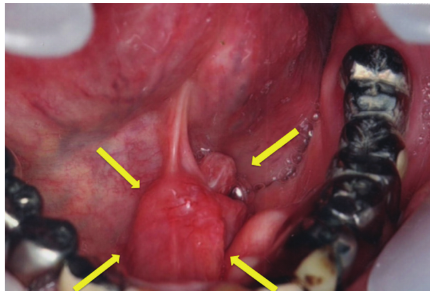
Figure 1: Examination showed a 22 × 15 mm mass with a granular surface in the middle of the mouth floor.